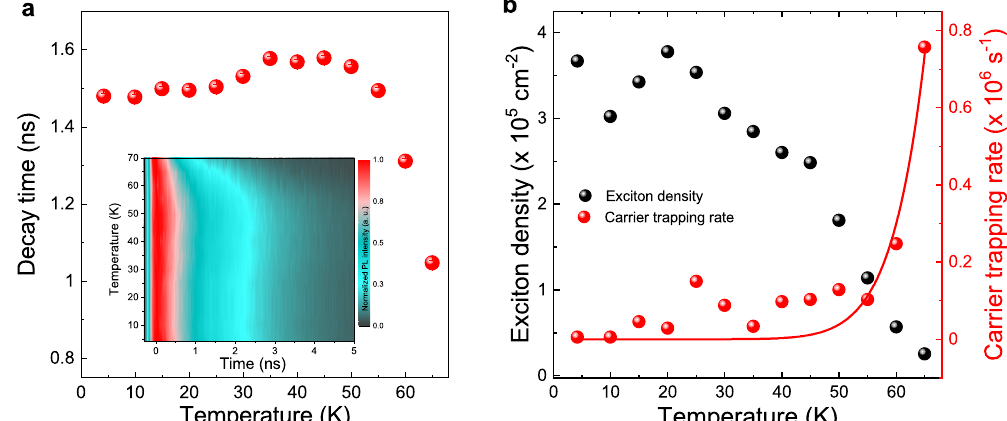
Fig. 4 Temperature-dependent time-resolved photoluminescence. a Decay time of the P1 emission peak as a function of temperature. Inset depicts the temperature-dependent time-resolved PL of the P1 emission peak measured at excitation power of 2 mW. We used a power that was as low as possible to avoid thermal effects. b Initial exciton density and carrier trapping rate, which is related to free carrier density n f , as a function of